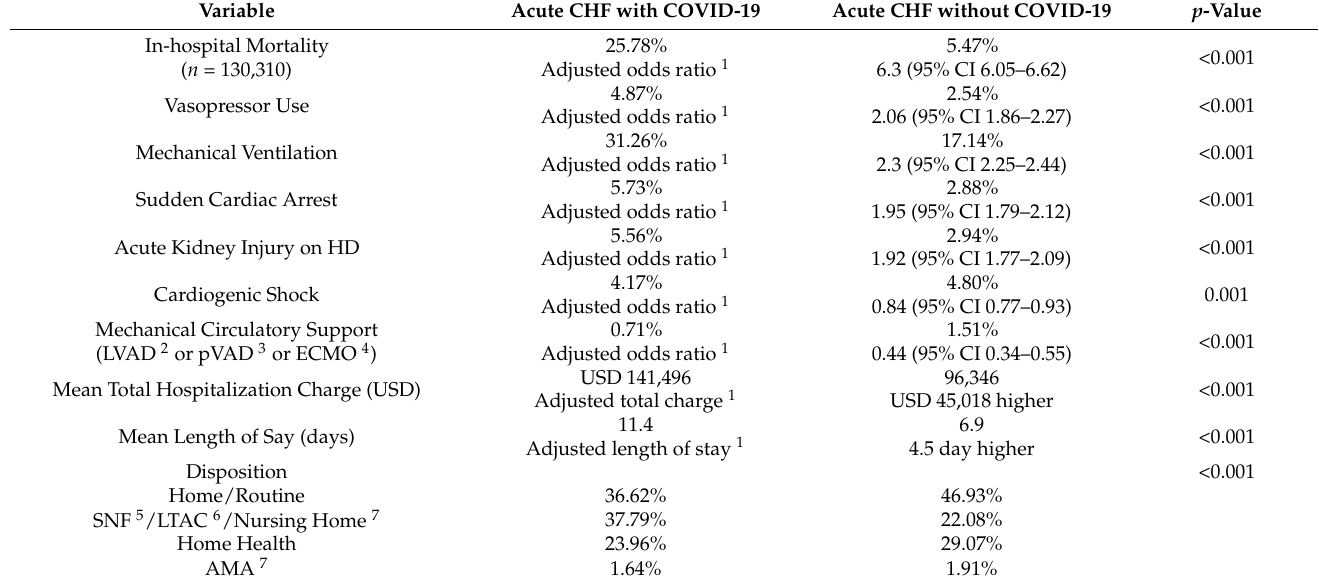
Table 2. In-hospital outcomes of Acute Congestive Heart Failure (CHF) in COVID-19 Positive and Negative